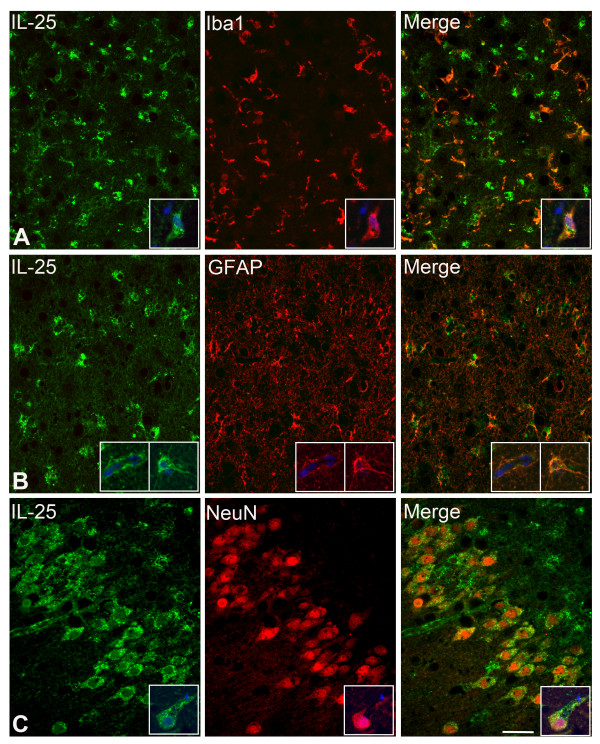
IL-25 IR in neurons, astrocytes and microglia. IFC reveals IL-25 IR (in green) co-localizing with three CNS cell type markers (red), (A) Iba1, a microglial marker, (B) GFAP, an astrocytic marker and (C) NeuN, a neuronal marker. Panel A,B: CA4; Panel C: dentate gyrus. Note that IL-25 IR is also present in the astrocytic endfeet surrounding the bloodvessels (B). The insets are higher power magnifications taken from a representative area, with the added nuclear marker DAPI (blue). Scale bar = 40 μm